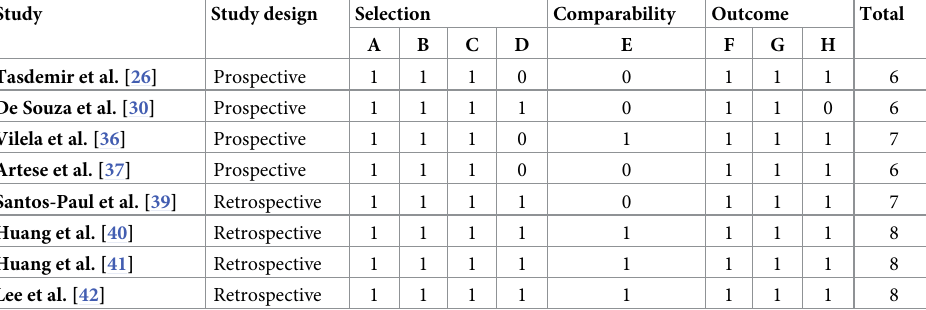
Table 5. Newcastle-Ottawa quality assessment scale (studies including control groups).